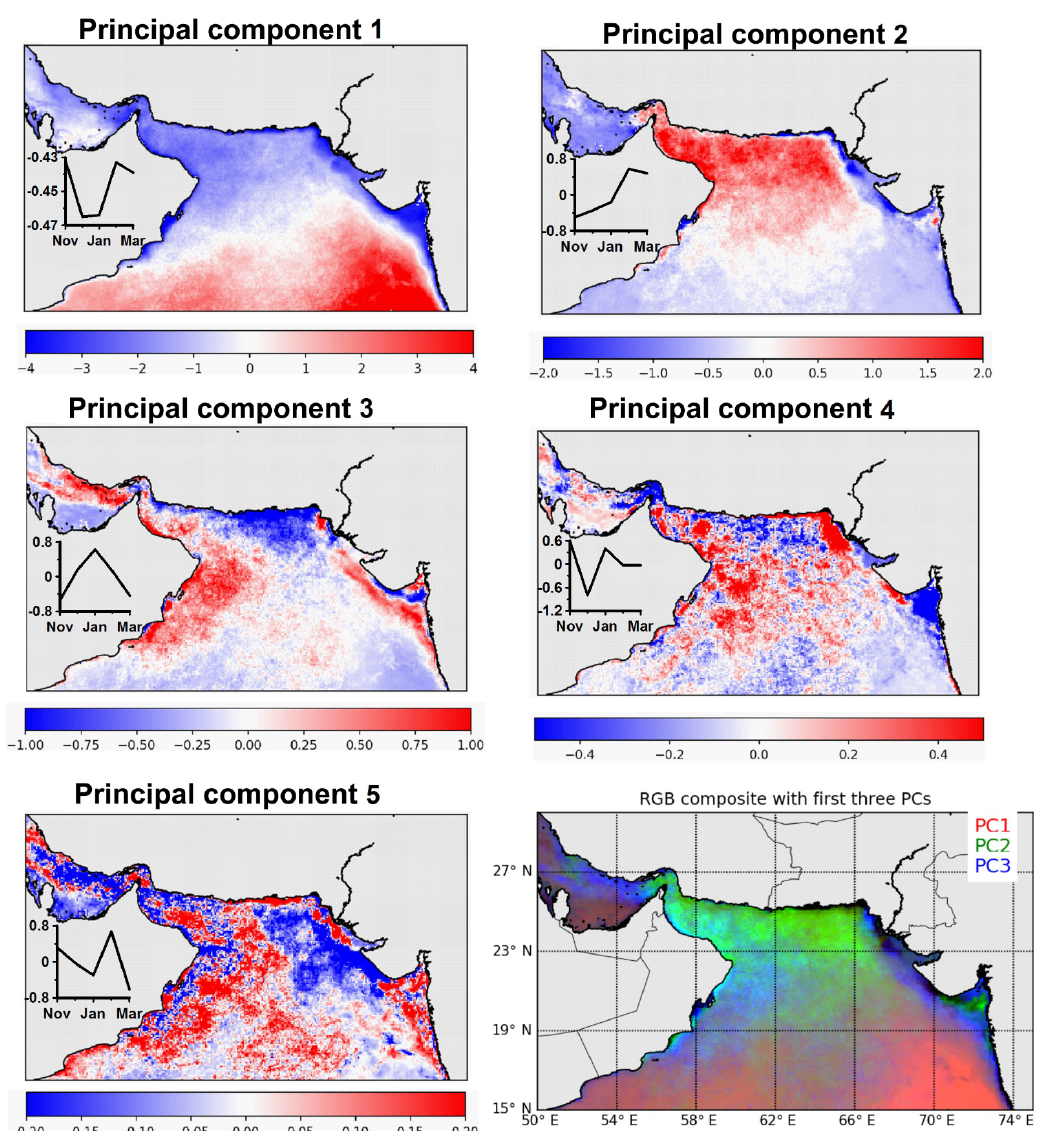
Figure 2. Individual maps of principal components (PC 1 to 5) and RGB composite of the first three statistically significant components. Corresponding to each PC, the respective periodicity is